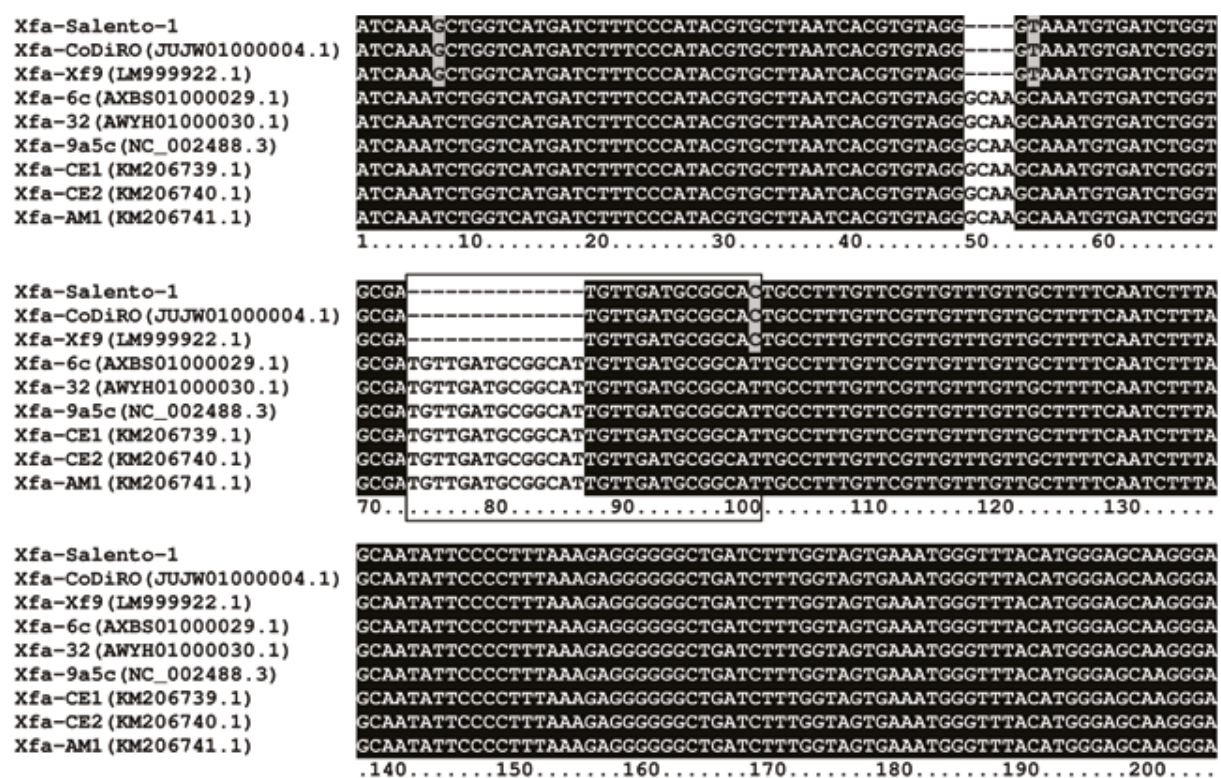
Figure 6. Alignment of a fragment of the intergenic region downstream the 3′ end of rpoD from nine Xylella fastidiosa subsp. pauca strains. Strains Salento-1, CoDiRO and Xf9 were isolated in Apulia from olives affected by the quick decline syndrome; strains 9a5c (citrus), 6c and 32 (coffee) were isolated in Brazil; uncultured Xylella strains CE1, CE2 and AM1 were detected in olive plants in Argentina. SNP’s and indels are highlighted, respectively, in gray and white. The repeat sequence of two 14 bp units reported as characteristic of strain 9a5c (Chen et al ., 2005) is boxed. The figure was drawn using BOXSHADE (http://mobyle.pasteur.fr